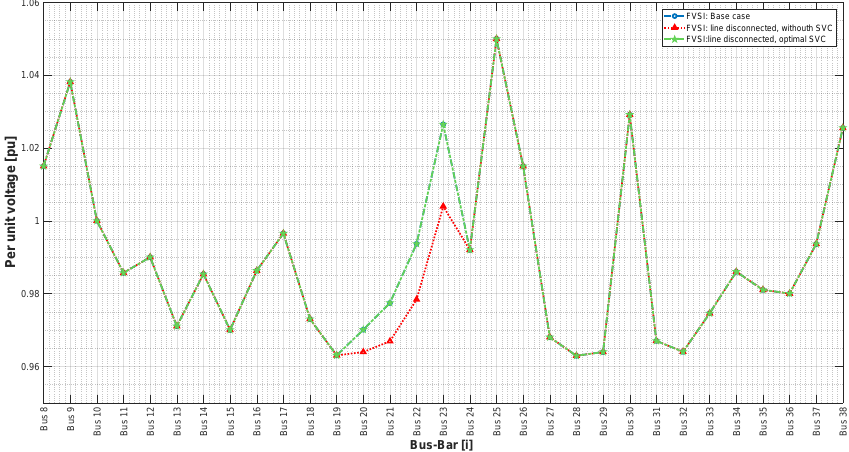
Figure 18. Third study case: Voltage profiles before/after contingencies and with SVC compensation.